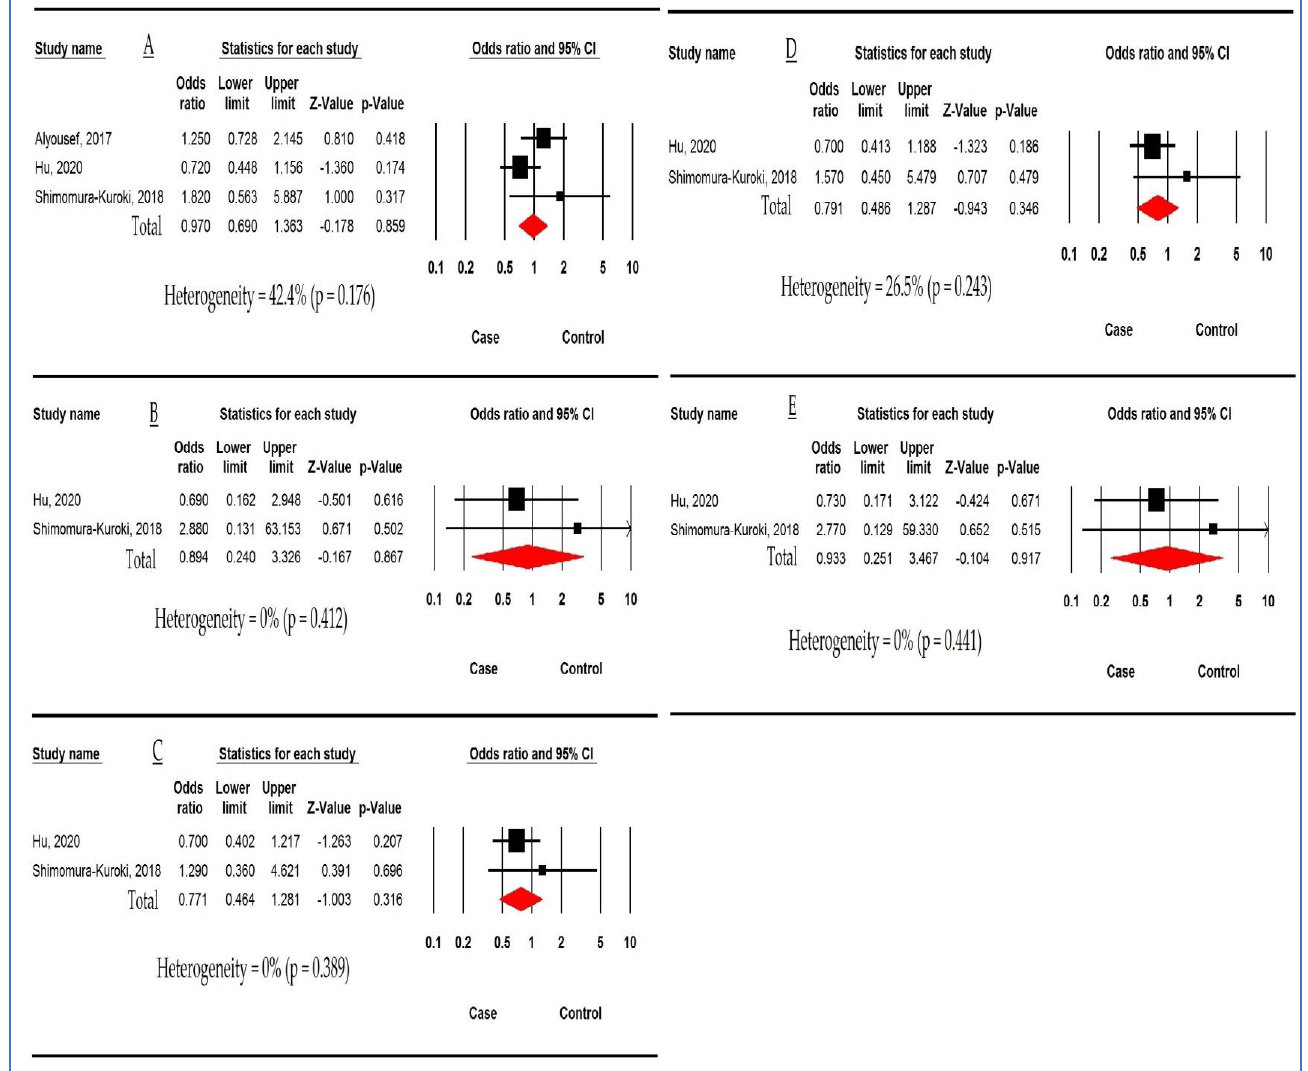
Figure 5. Forest plot for association between mannose-binding lectin 2 (MBL2) rs7096206 polymorphism and dental caries risk. ( A ) Allelic model. ( B ) Homozygous model. ( C ) Heterozygous model. ( D ) Dominant model. ( E ) Recessive model